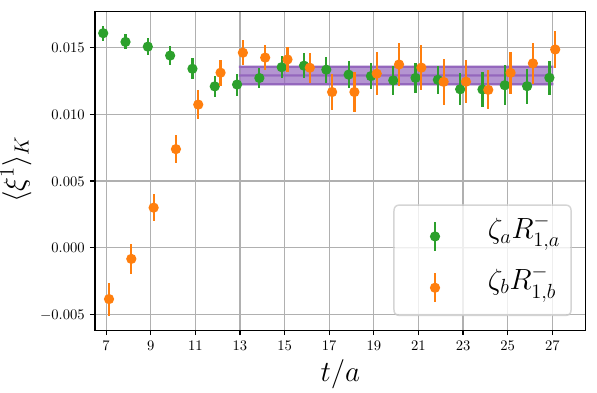
Figure 3 . The ratios corresponding to the renormalized moment as a function of the time t in lattice units for the example of ensemble J501 with a = 0 . 039 fm. The result of a combined fit to both ratios is depicted in